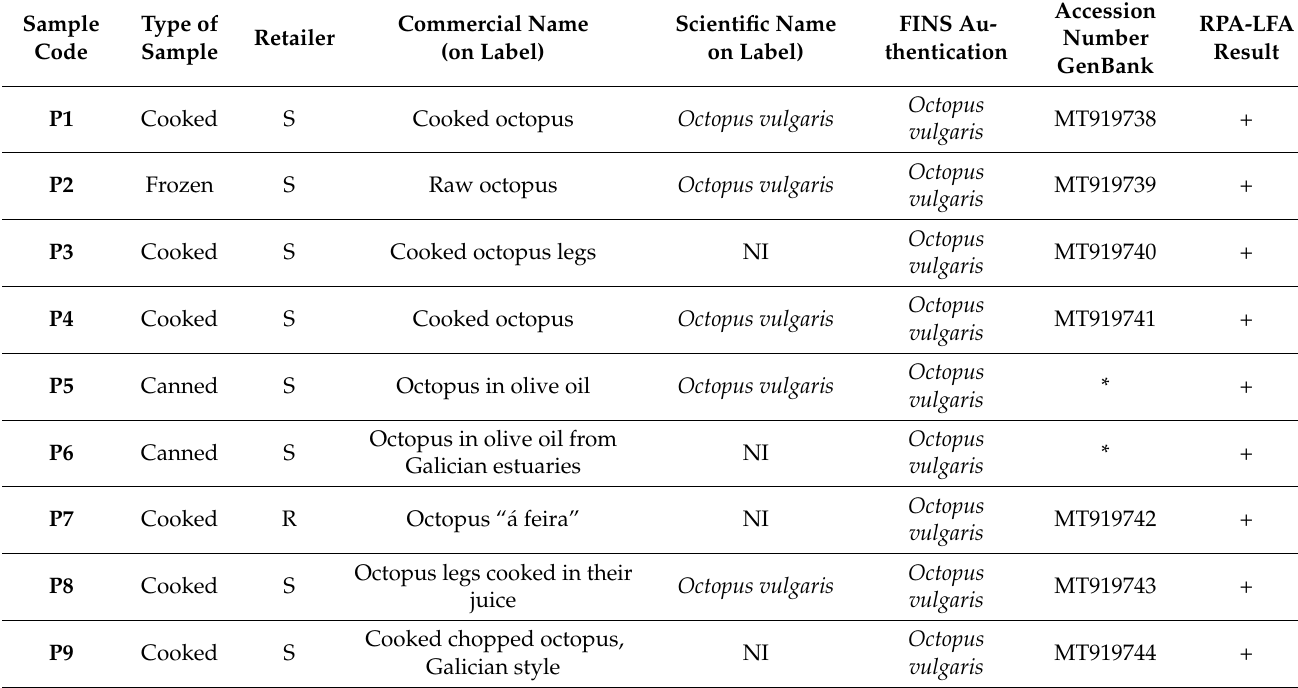
Table 2. Analyzed commercial samples with the indication of the type of sample and type of retailers where they were obtained (S: supermarket, R: restaurant), commercial name of the product (translated into English) and scientific name (if present, NI (Not indicated) if absent). The table also shows the FINS authentication results together with the GenBank accession number and RPA-LFA